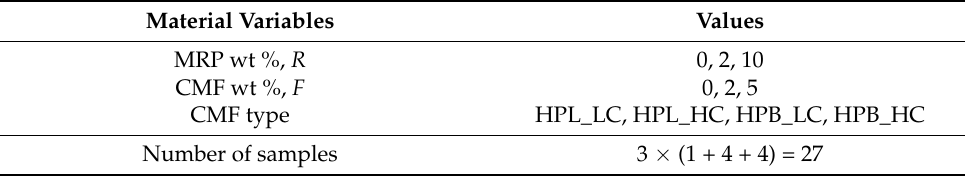
Table 1. Material variables for asphalt samples.